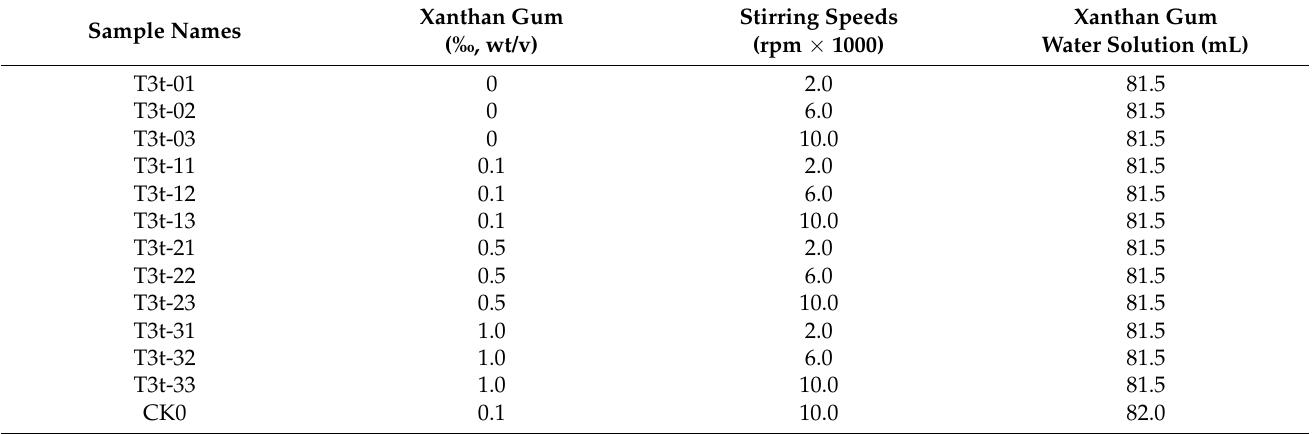
Table 3. Xanthan gum concentrations and stirring speeds for AZO-loaded NP